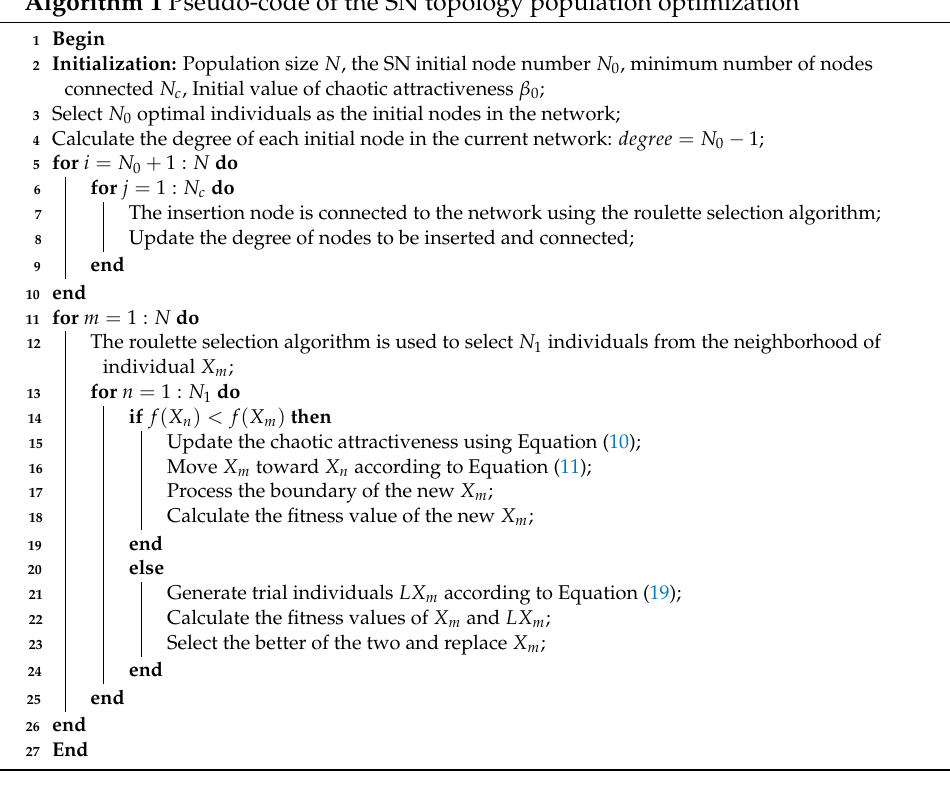
Algorithm 1 Pseudo-code of the SN topology population optimization